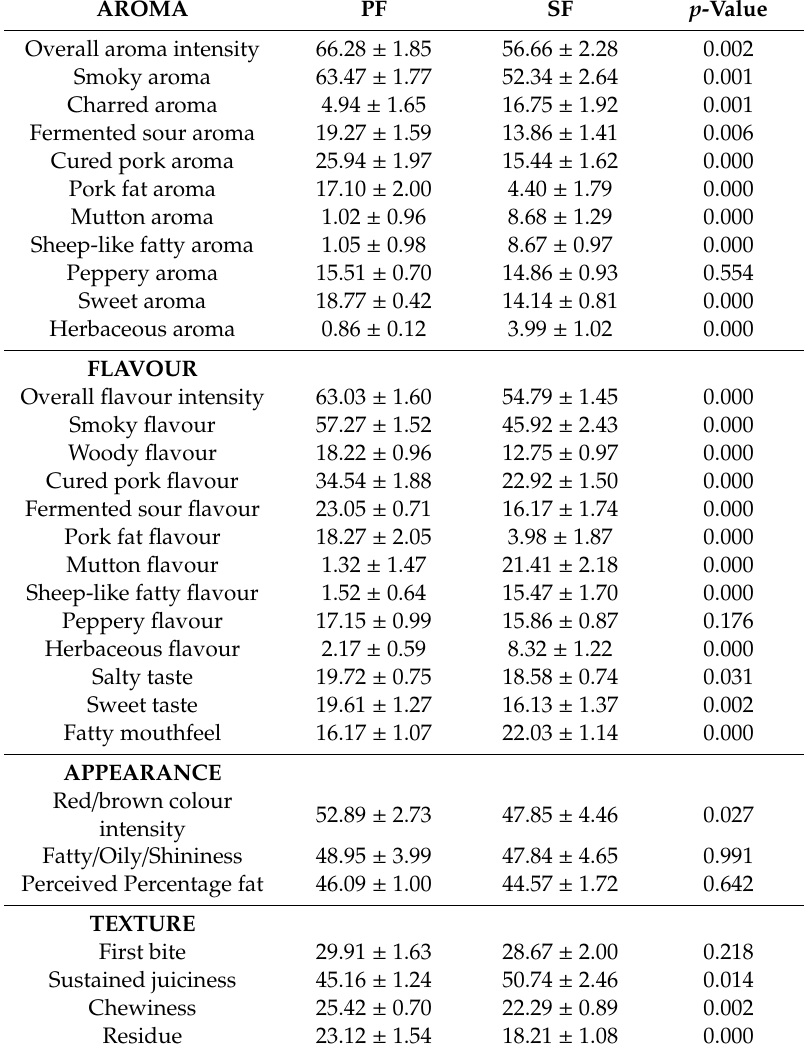
Table 5. Sensory attributes of cabanossi made with either pork backfat (PF) or sheep tail / backfat (SF).